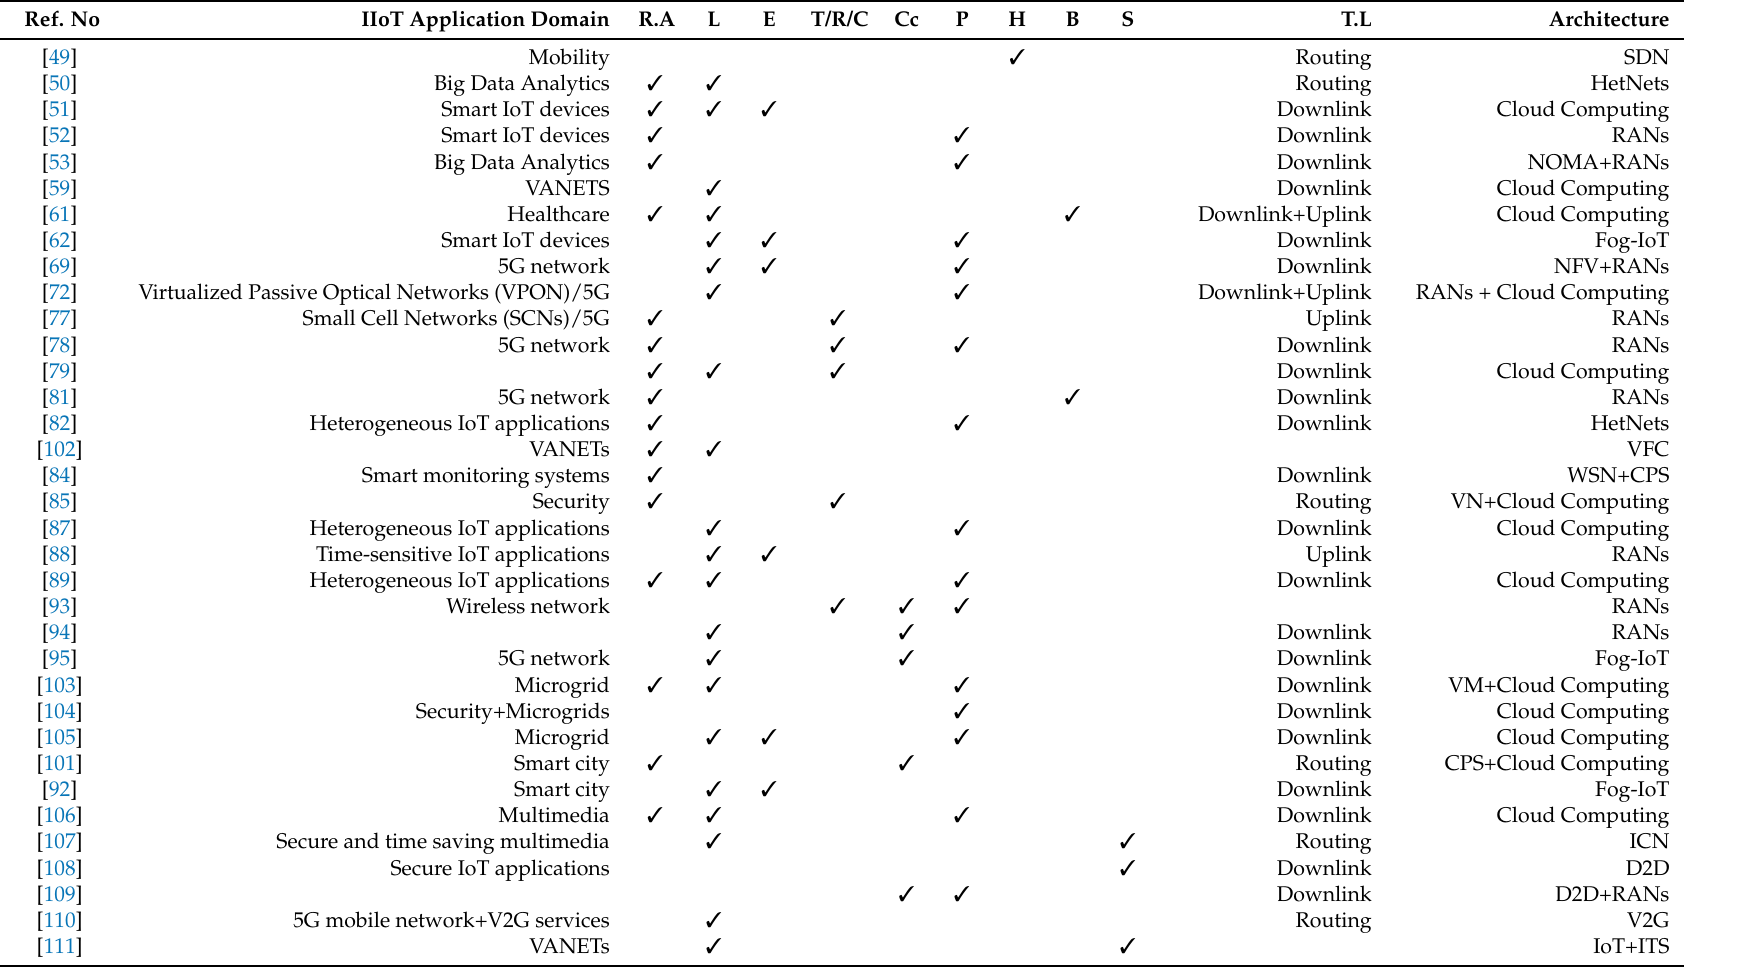
Table 1. Literature Review: R.A=Resource Allocation, L=Latency, E=Energy, T/R/C=Throughput/Rate/Capacity, Cc=Cache, P=Power, H=Handover, B=Bandwidth, S=Security, T.L=Transmission